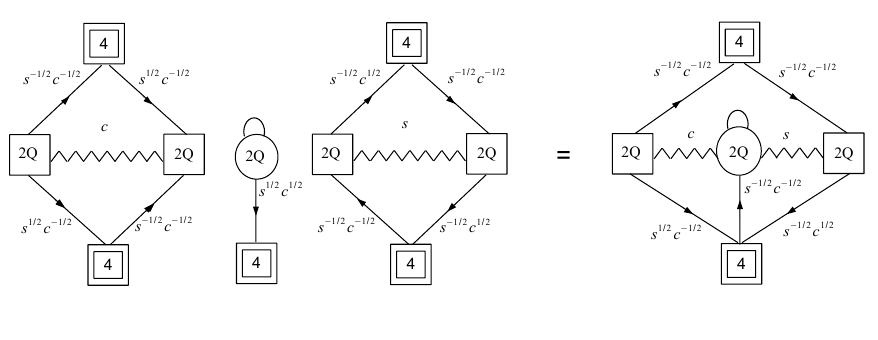
Figure 11: Example of gluing two basic tubes together with a non-trivial element of the Weyl group of SO ( 16 ) . The resulting tube will have flux ( 1,1,1,1,0,0,0,0 ) .